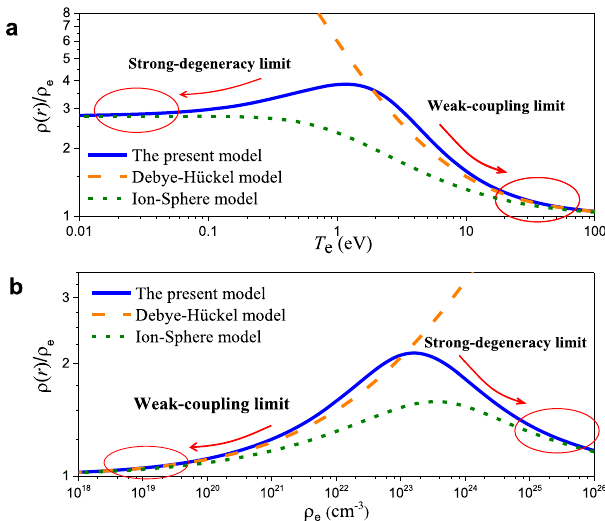
Fig. 2 Comparison of plasma electron density between different models. The electron densities ρ r ð Þ = ρ at the position r with Φ r ð Þ ¼ 1 = ð 4 πε 0 a WS Þ e with different temperatures and densities. a The electron densities ρ r ð Þ = ρ e are shown as a function of temperature T e with the fi xed mean electron ¼ 1 ´ 10 22 cm (cid:2) 3 . b The electron densities ρ r ð Þ = ρ density being ρ are shown e e ¼ 10 eV. The solid lines as a function of ρ with the fi xed temperature T e e are the results of the present model and the ones of Debye – Hückel and ion- sphere models are shown in dash line and short dash line, respectively.